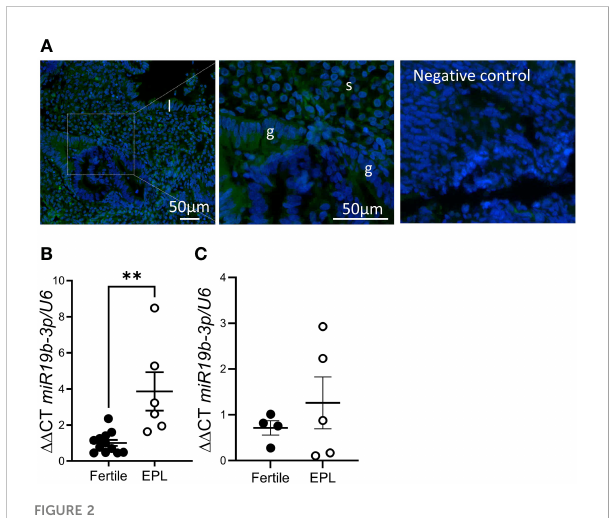
FIGURE 2 miR-19b-3p expression is elevated in endometrium from women with a history of early pregnancy loss. (A) In situ hybridization of miR-19b-3p in endometrium. Localization of miR-19b-3p indicated by green fl uorescent staining. DAPI (blue) counterstaining identi fi es nuclei. (B) qPCR of miR-19b-3p in endometrium from fertile patients and patients with a history of early pregnancy loss (EPL). (C) qPCR of miR-19b-3p in serum from fertile patients and patients with a history of early pregnancy loss. g, glandular epithelium; l, luminal epithelium; s, stroma; Data shows mean ± SEM; **P<0.01; (B, C) , paired t-test.